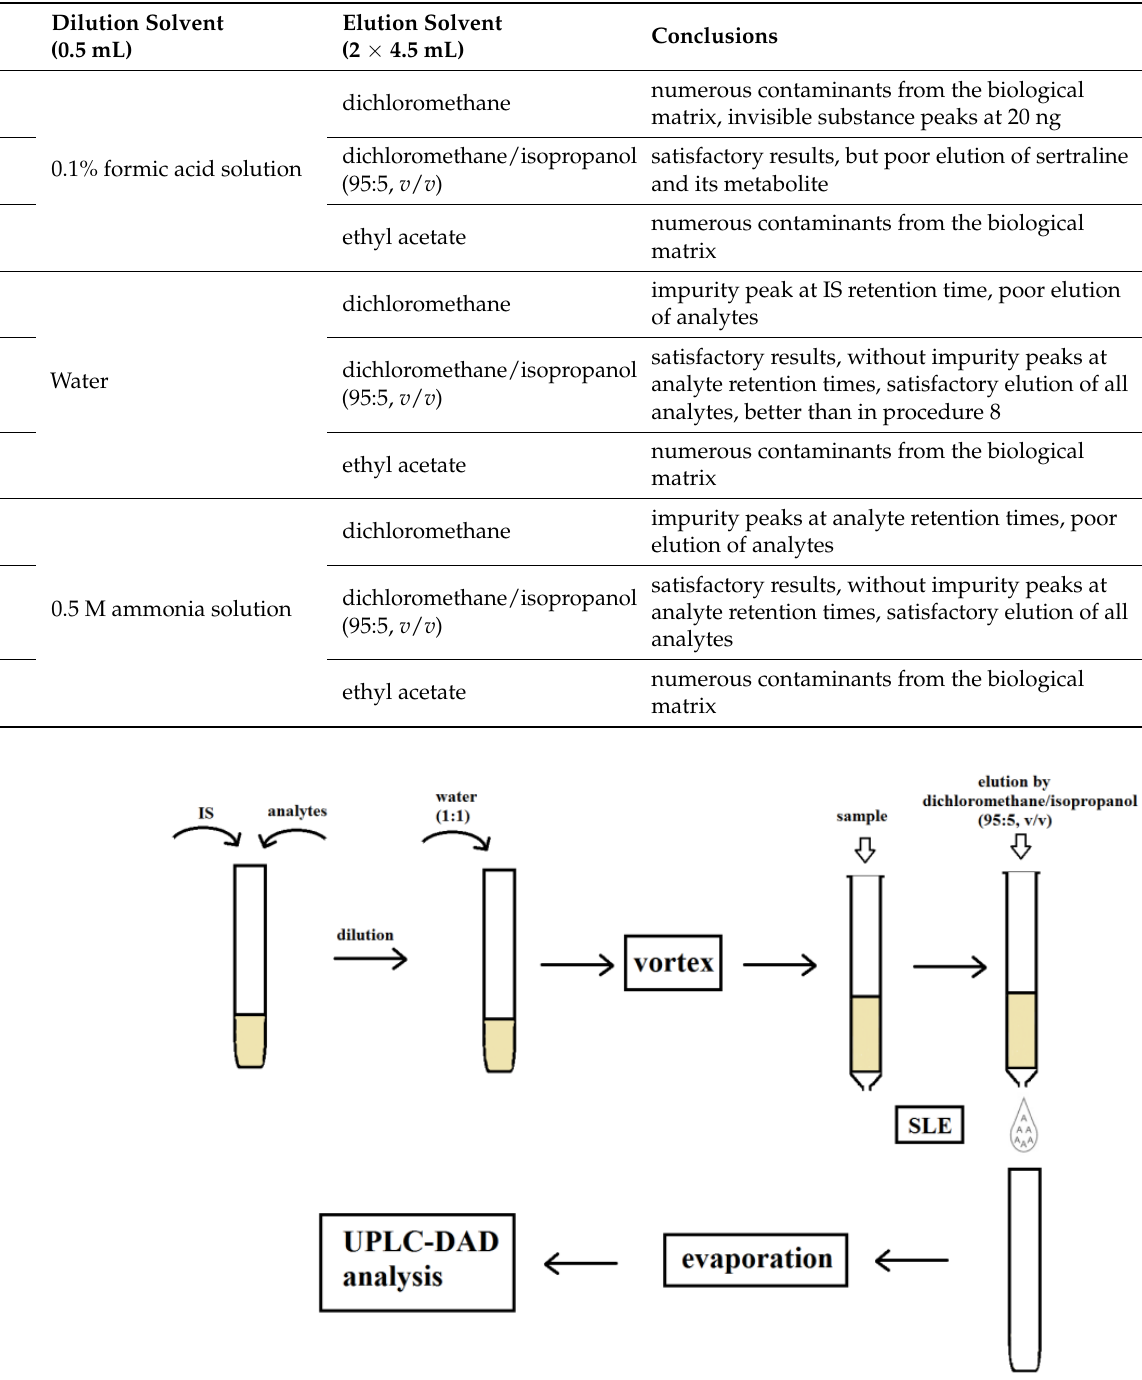
Figure 4. (A) Chromatogram of saliva sample extract obtained spiked with 100 ng/mL; (B) chro- matogram